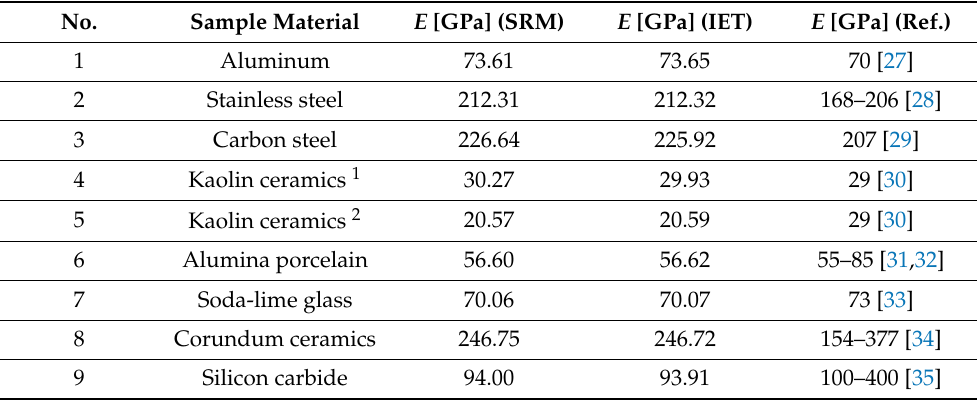
Table 3. Young’s modulus of used materials determined by SRM and IET methods, and Young’s modulus from the